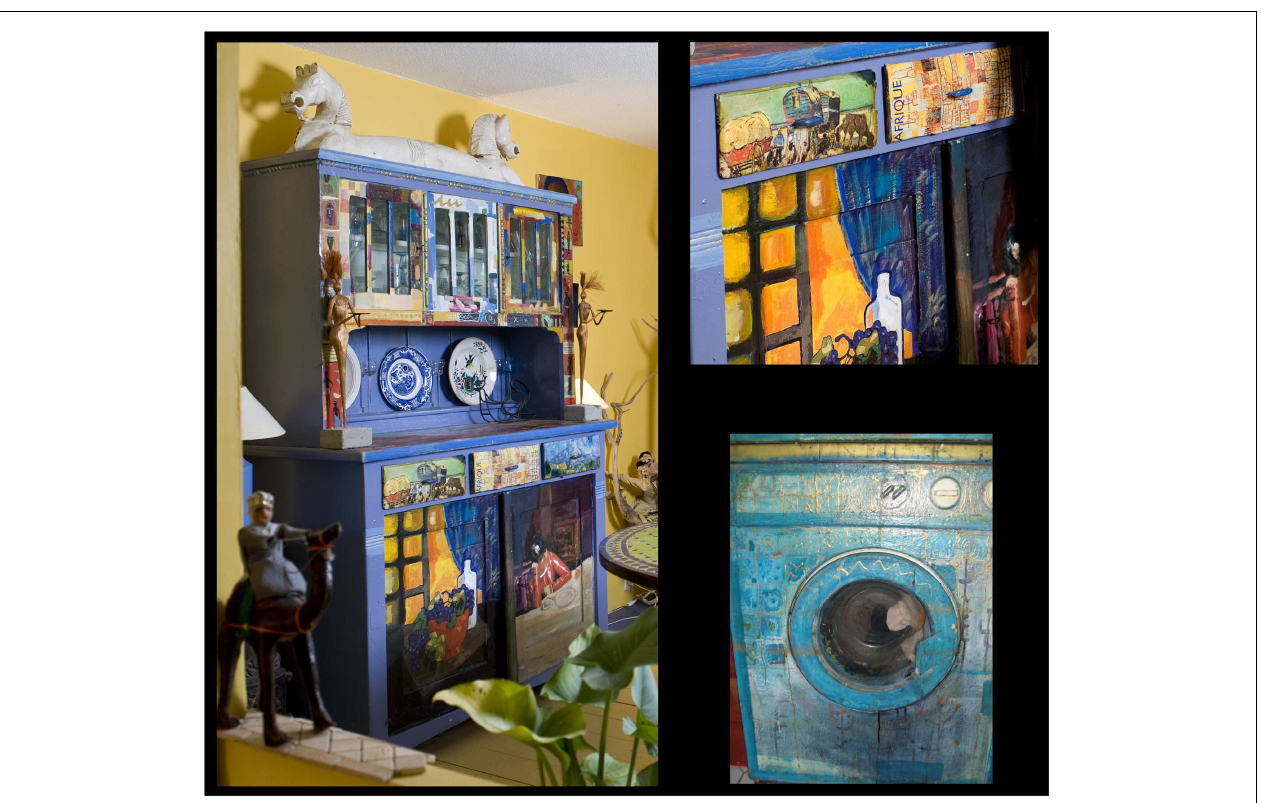
FIGURE 3 |Addictive period . Examples of furniture and equipment being transformed in pieces of art illustrating the change in quantity and in surfaces of